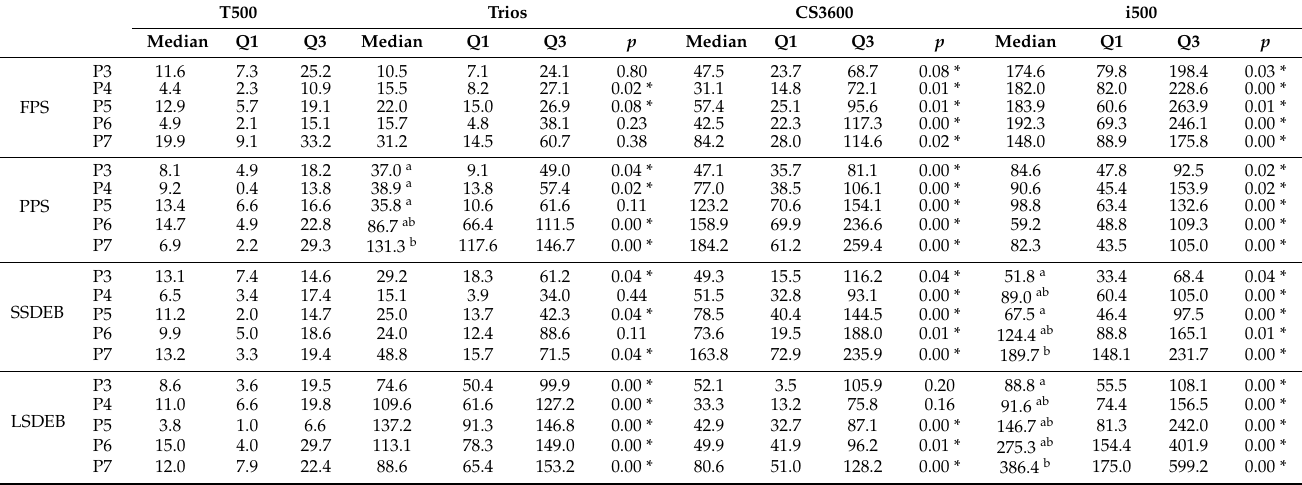
Table 3. The unsigned difference of experimental models (FPS, PPS, SSDEB, LSDEB) by the various scanner (T500, Trios, CS3600, i500). IQR (Median, Q1, Q3) of RMS values are presented in micrometers. IQR: Inter Quartile Range, RMS: Root Mean Square, FPS: Full Posterior Support, PPS: Partial Posterior Support, SSDEB: Short Span Distal Extension Base, LSDEB: Long Span Distal Extension Base, P3 to P7: Position 3 to Position